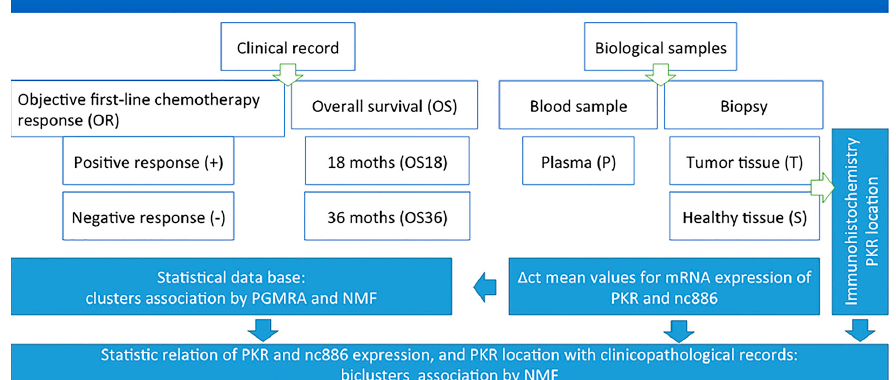
Figure 1. Flowchart of the ambispective study.